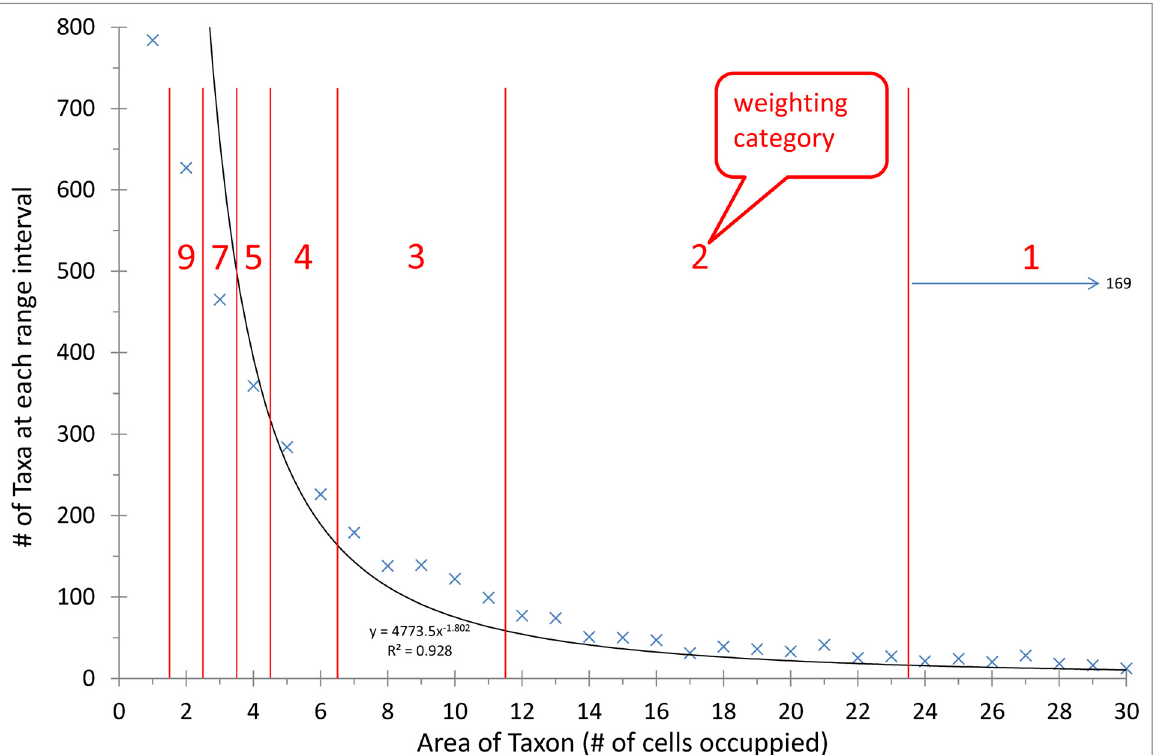
Fig 2. A histogram of the number of taxa in each of the taxon area sizes. The 4 304 taxa analysed were divided into bins dependent on the number of cells they occupied, and the frequency in each bin was calculated. A regression line was then plotted between the bin size and its taxon number. The regression line, graph equation (used for integration), and the goodness of fit value (R 2 ) are indicated on the graph.